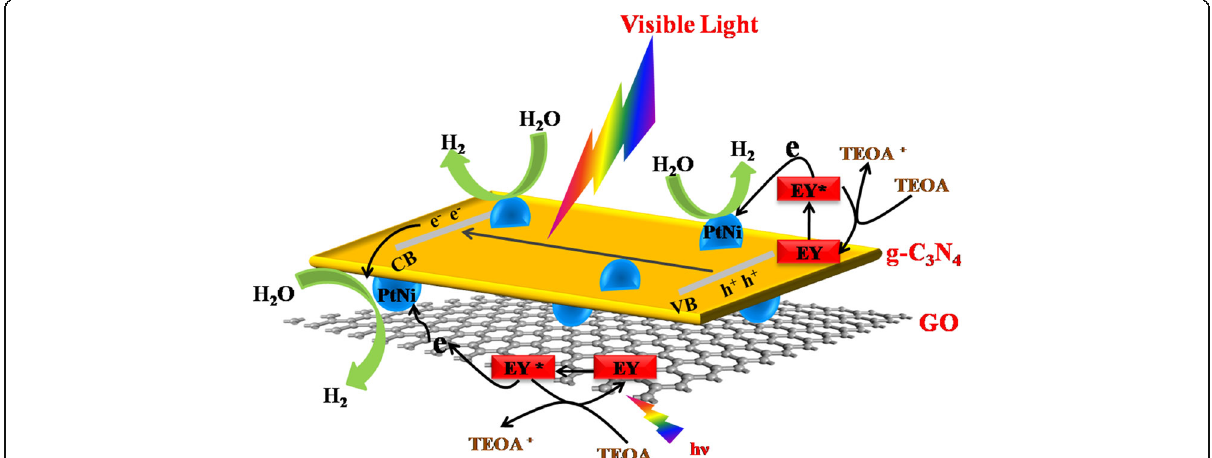
Fig. 9 A schematic diagram of H 2 evolution process for the Eosin Y-sensitized g-C 3 N 4 /PtNi/GO composite sample under visible light